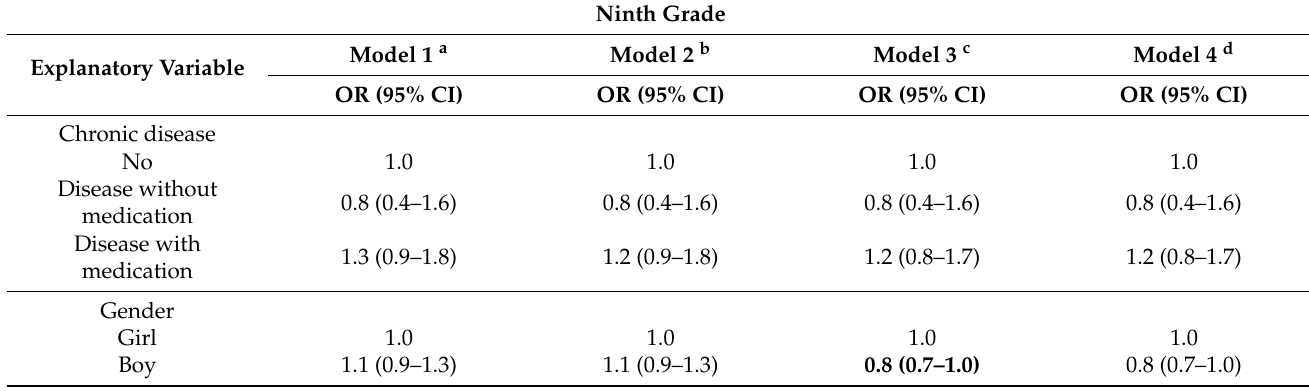
Table 5. The association of chronic disease in the ninth grade ( N = 7384) with the delayed start of upper-secondary school. Bivariate (Model 1) and adjusted logistic regression models (Model 2– 4). Odds ratios (OR) and their 95% confidence